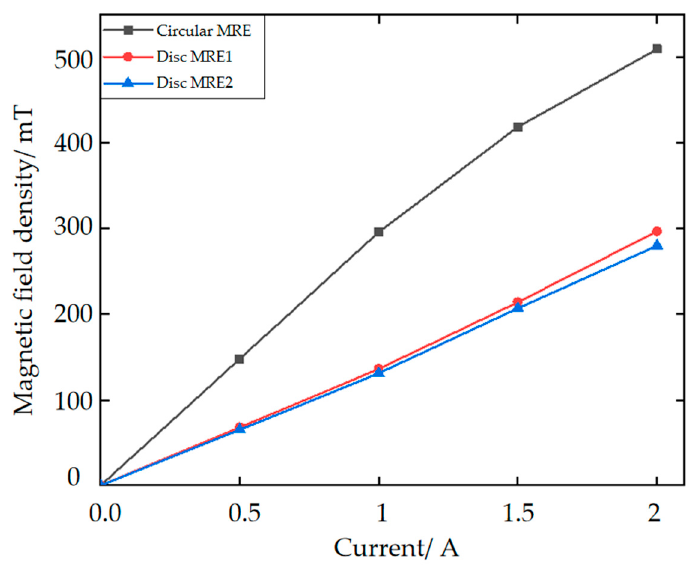
Figure 8. Trend of the magnetic induction strength with the current.